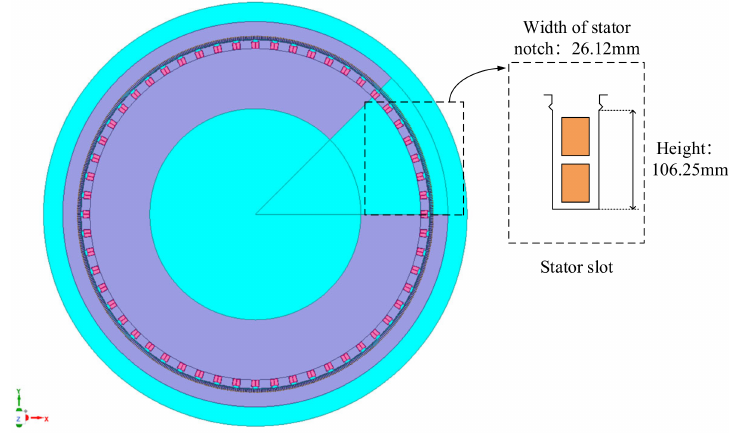
Figure 1. Structure of the proposed 1000 MW hydro generator.